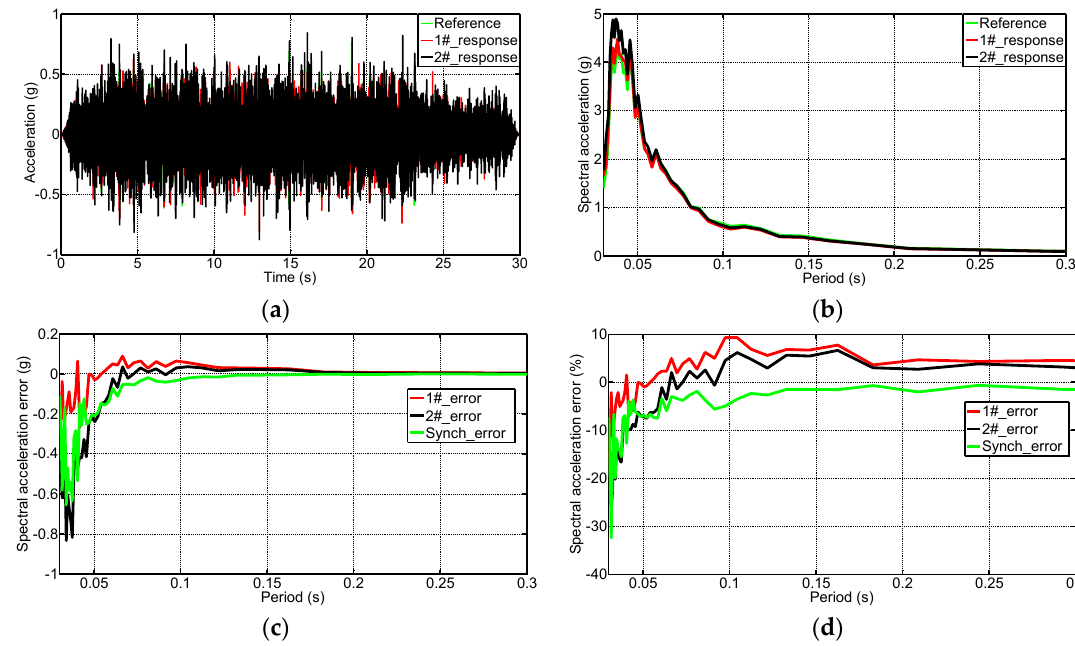
Figure 27. The acceleration results with proposed compound control. ( a ) Time domain; ( b ) Spectral acceleration; ( c ) Spectral acceleration errors (absolute); ( d ) Spectral acceleration errors (relative).